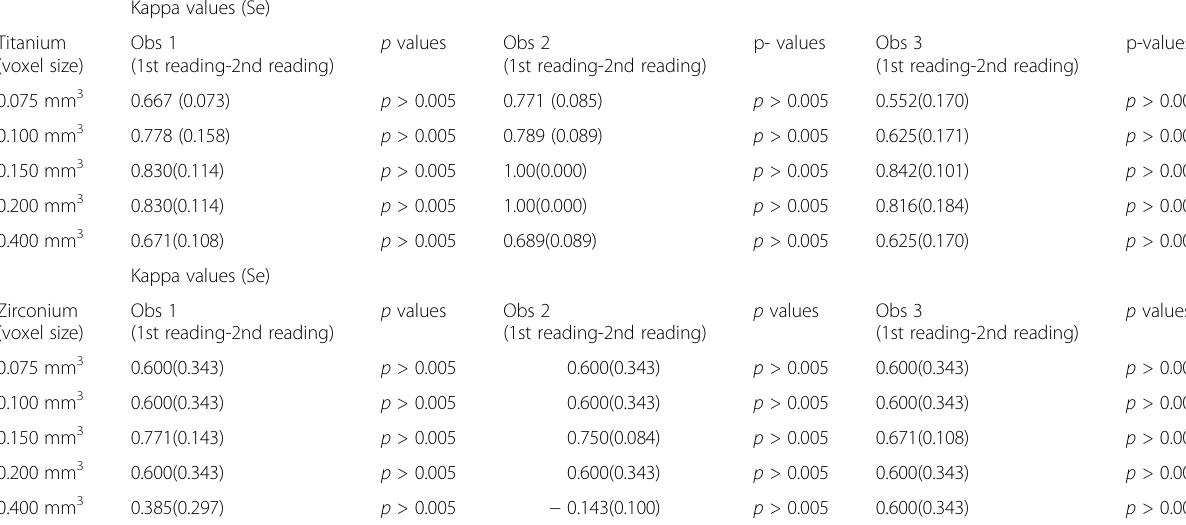
Table 1 Intraobserver kappa values calculated by scan modes and implant types for each observer